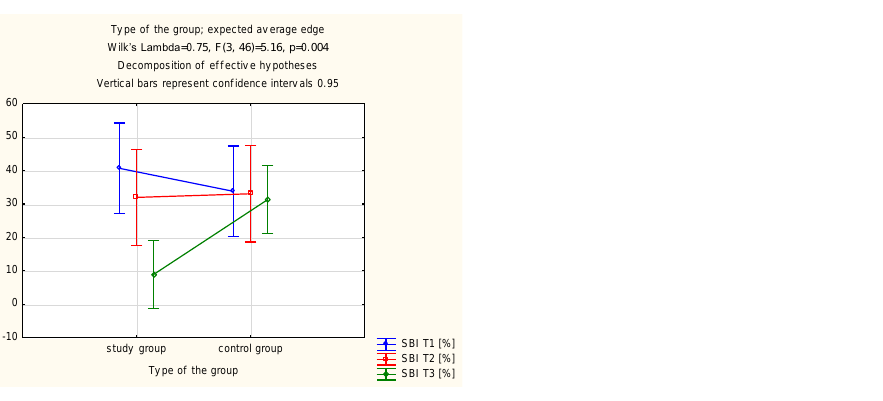
Figure 4. Estimated marginal means for the modified sulcus bleeding index (mSBI) in the study and control groups.